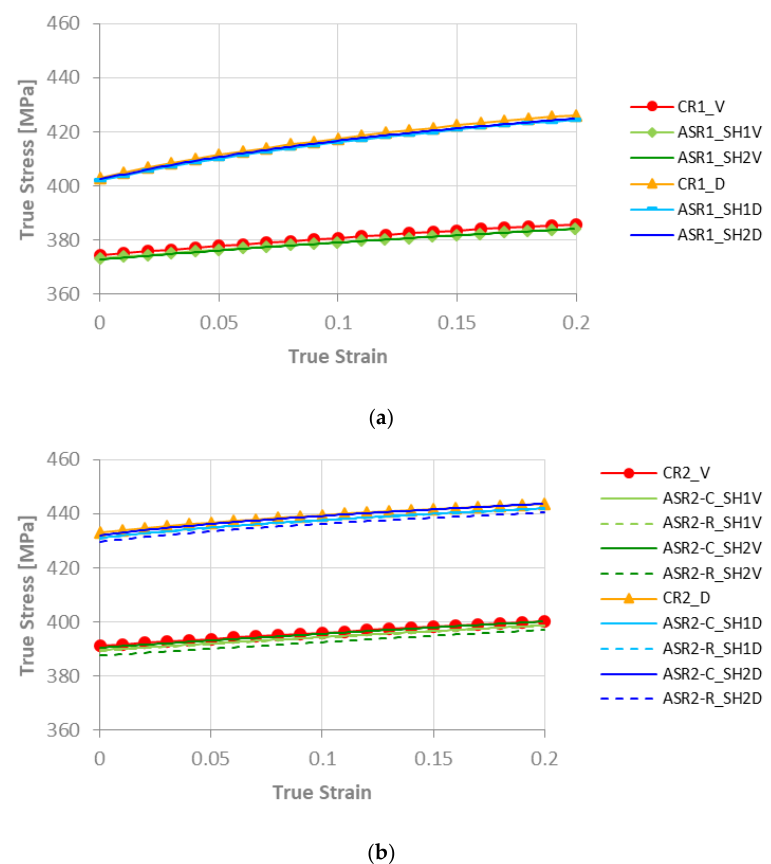
Figure 9. Stress – strain curves after a thickness reduction of 30% per pass of CR, ASR-C, and ASR-R simulations using two different hardening laws, Voce-type (V) and DDR (D), and two different shear strain values, (SH1) and (SH2), for the asymmetric rolling: ( a ) 1st pass and ( b ) 2nd pass. In Figure 10, it is clear there is an increased yield stress trend despite the rolling se- quence. That is, curves from the 2nd pass are consistently above those from the 1st pass. Additionally, the shear strain value does not have a significant impact. Curves (SH2) are slightly above curves (SH1).